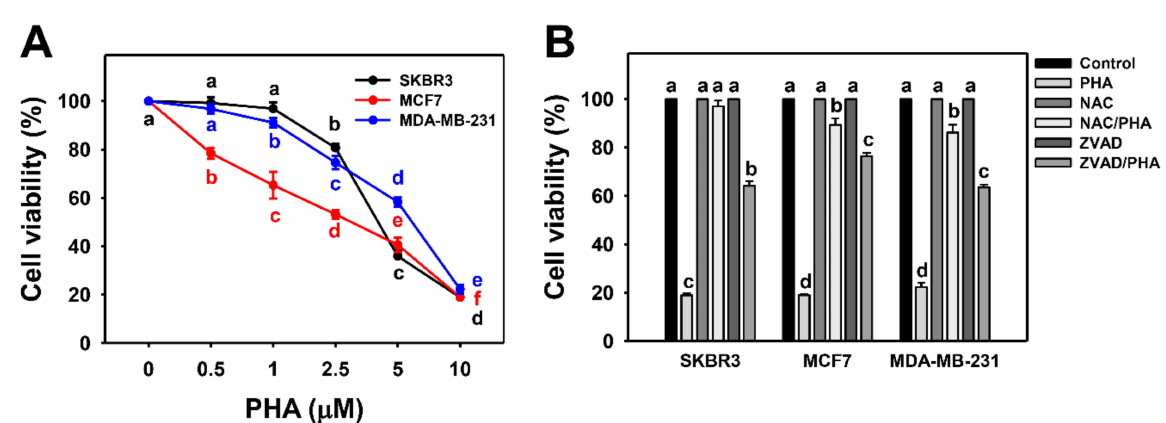
Figure 1. Physapruin (PHA) decreased ATP- detected cell viabilities of breast cancer cells. ( A ) Concentration effect of PHA in an ATP assay. As indicated, three breast cancer cell lines were incubated with 0 (0.05% DMSO as control), 0.5, 1, 2.5, 5, and 10 µ M PHA for 24 h. ( B ) NAC or ZVAD pretreatment responses in ATP changes in PHA-treated breast cancer cells. Cells pretreated with either NAC (10 mM for 1 h) or ZVAD (100 µ M for 2 h) and post-treated with 0 (control with 0.05% DMSO) and 10 µ M PHA for 24 h, i.e., NAC/PHA or ZVAD/PHA. Data, means ± SDs ( n = 3 independent experiments). Experiments without the same top-labeled letters indicate significant changes according to a multiple ANOVA comparison ( p < 0.05 to 0.0001).